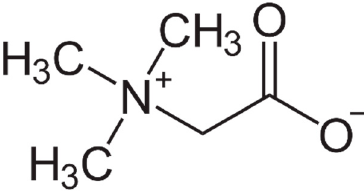
Figure 1. Structure of betaine.